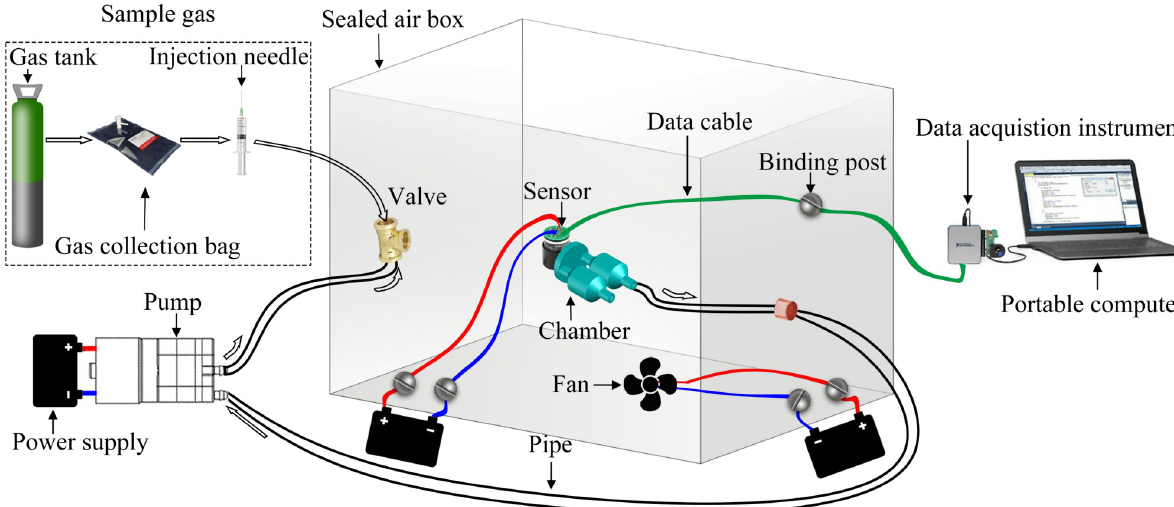
Fig 6. Schematic diagram of experimental electronic nose detection